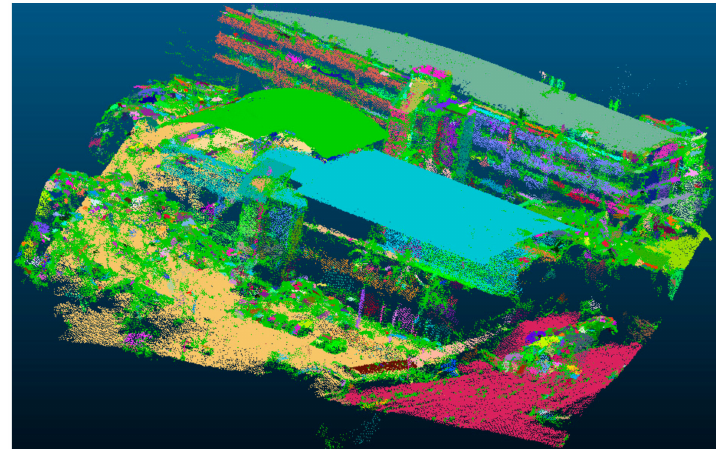
Figure 7. Segmentation result of Dataset1. Points in the same segment were assigned the same